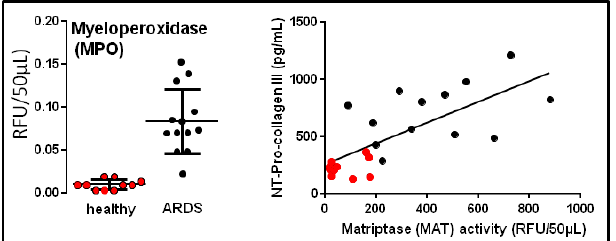
Figure 3. Association between sustained enzymatic protease activities (e.g., myeloperoxidase (MPO), matriptase (MAT)) in bronchoalveolar lavage (BAL) fluids, suggesting unresolved inflammation, and increased levels of N terminal (NT) procollagen III fragments in human ARDS. Individual values obtained in healthy volunteers are in full red circles ( n = 10), and those of human ARDS are in full black circles ( n = 13) [67–69]. See Supplementary Materials.